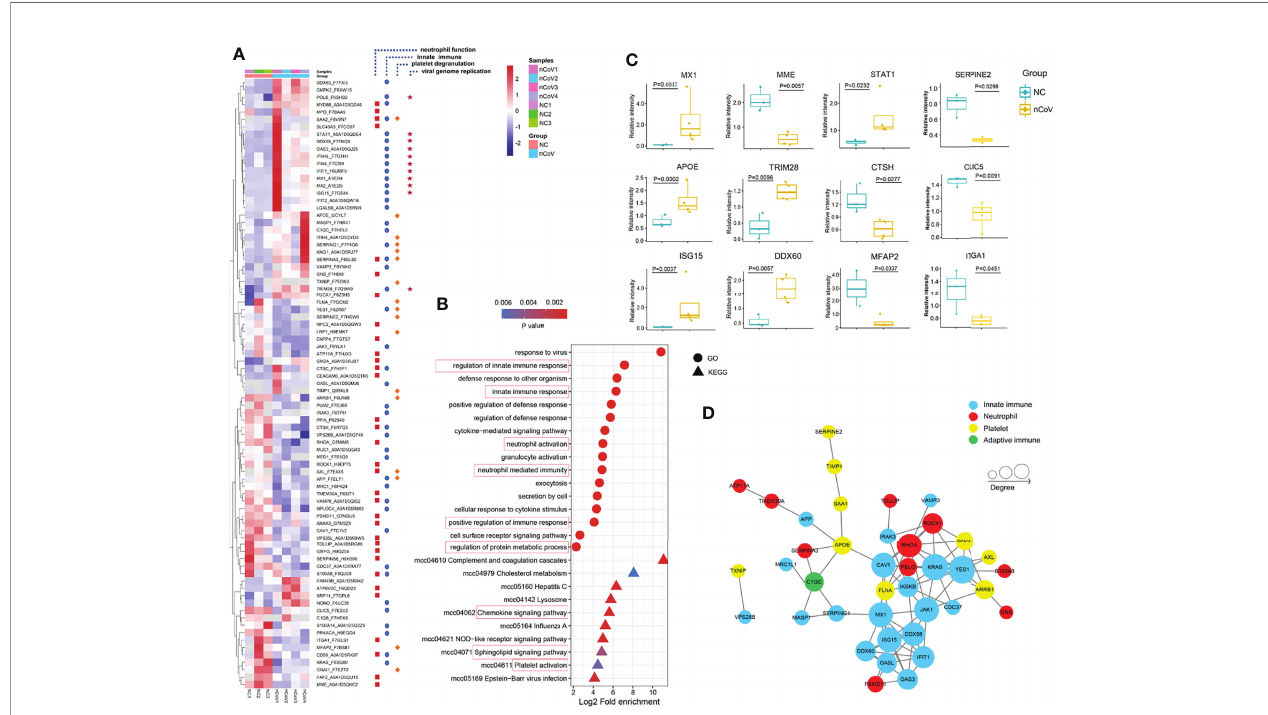
FIGURE 6 | Dysregulated Proteins in lung tissue of monkeys inoculated with SARS-CoV-2, and statistics of functional enrichment. (A) Heatmap of 83 selected proteins whose regulation concentrated on four enriched pathways. (B) The median CV values was analyzed to con fi rm the proteomics data with good degree of consistency and reproducibility (median<0.25). (C) The expression level change of nine selected proteins with signi fi cant difference before and after inoculated with SARS-CoV-2. (D) The histogram of GO terms enriched in biological process, cellular component and molecular function. CV, coef fi cient of variance; GO, Gene